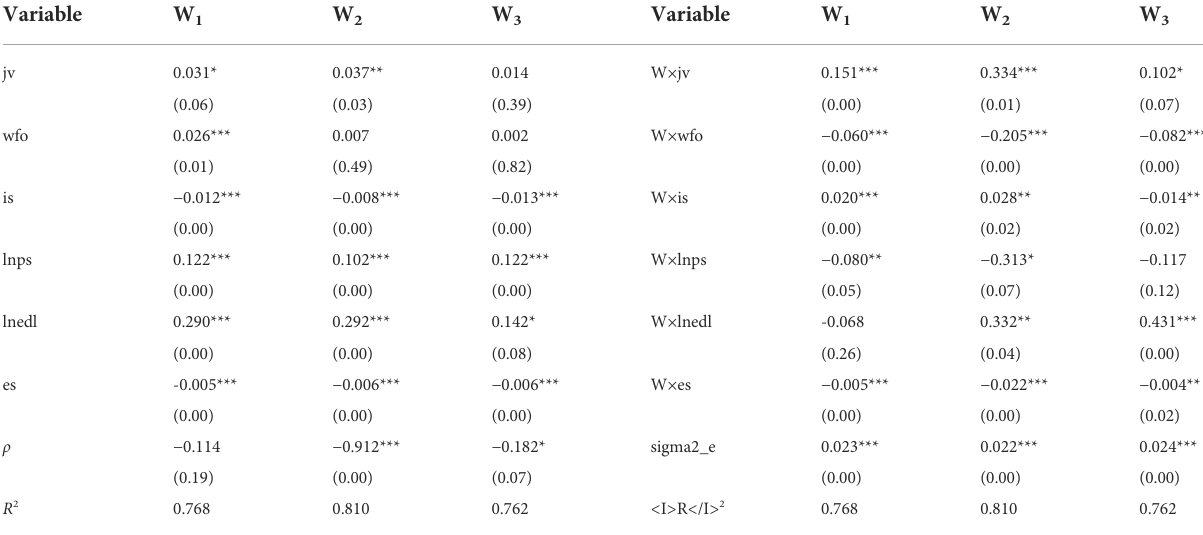
TABLE 5 Regression results of spatial Durbin model.